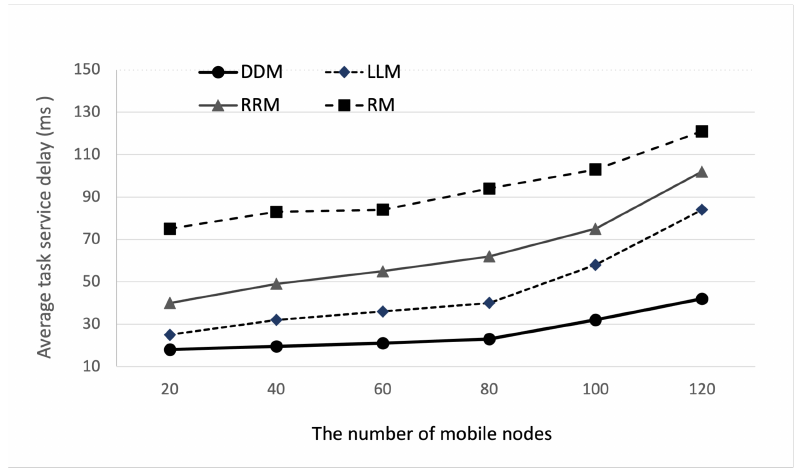
Figure 9. Average task service delay according to the number of mobile nodes.